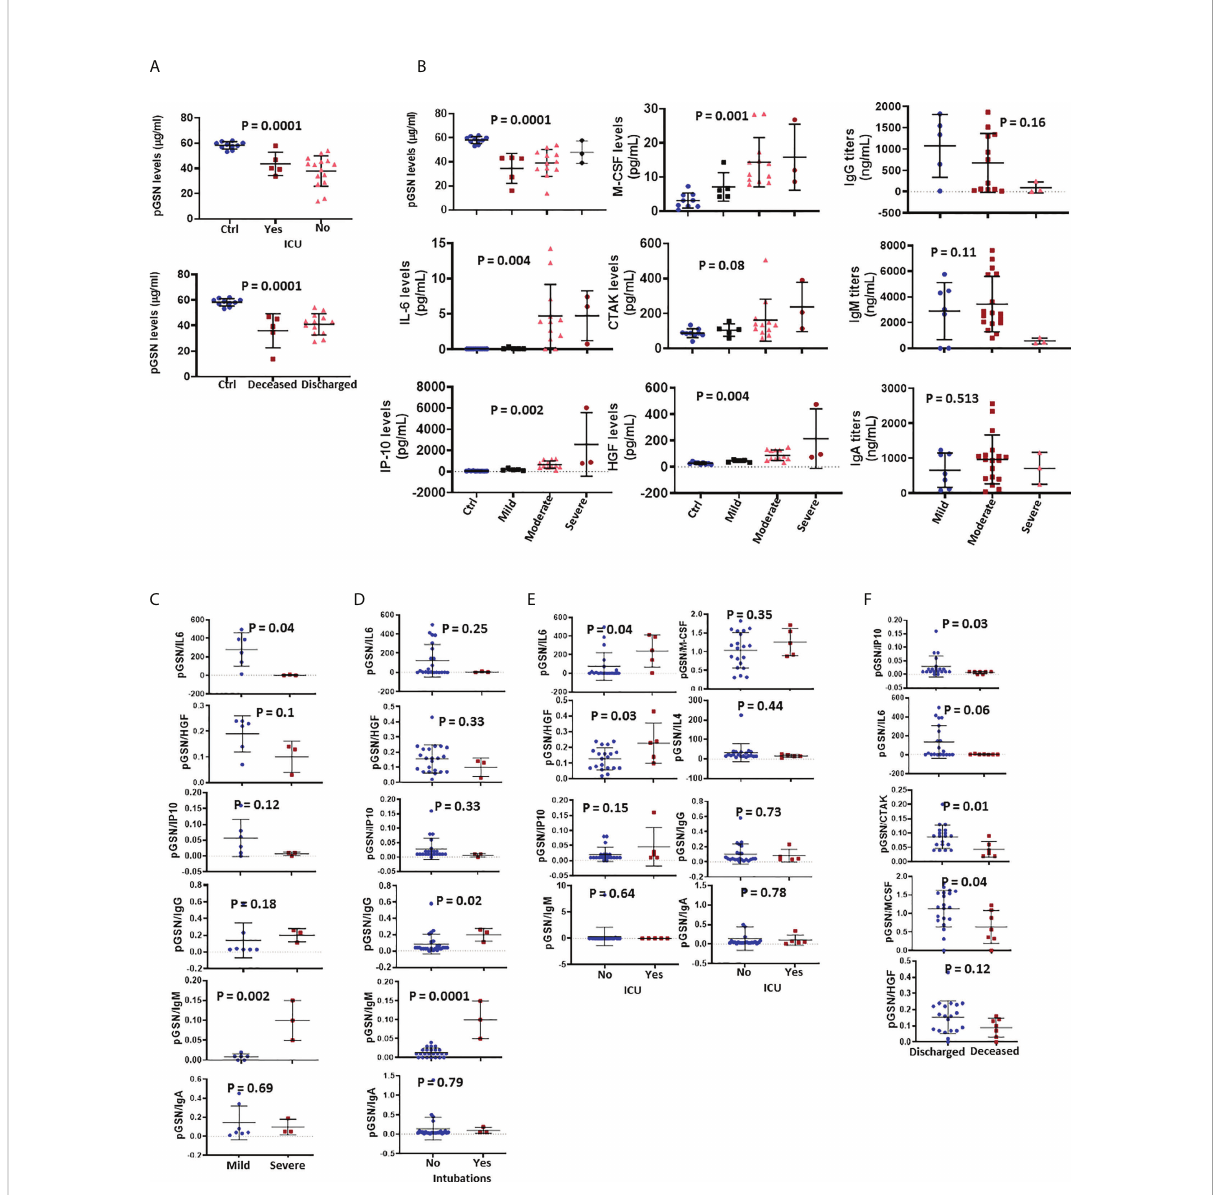
FIGURE 2 The combination of pGSN and IL-6, IP-10, HGF, CTAK and M-CSF is associated with favorable COVID-19 outcomes. (A) pGSN levels at day 0 were determined and the mean ± SEM compared between patients based on ICU admittance and hospitalization outcome. (B) The mean ± SEM levels of pGSN, IL-6, IP-10, M-CSF, HGF, CTAK, IgA, IgM and IgG were detected and compared between patients based on disease severity. The ratio of pGSN and cytokines were calculated and used as multi-analyte diagnostic panels. (C) The mean ± SEM levels of pGSN/IL-6, pGSN/HGF, pGSN/IP-10, pGSN/ IgG, pGSN/IgM and pGSN/IgA were determined and compared between mild and severe COVID-19 patients as well as (D) intubation status and (E) ICU admittance with pGSN/IL-4 included. (F) The mean ± SEM levels of pGSN/IP-10, pGSN/IL-6, pGSN/CTAK, pGSN/M-CSF and pGSN/HGF were compared between deceased and discharged patients. P-values were calculated by one-way ANOVA and independent sample